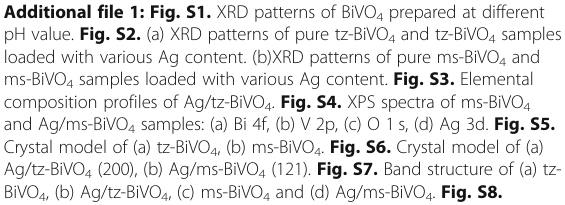
Additional file 1: Fig. S1. XRD patterns of BiVO 4 prepared at different pH value. Fig. S2. (a) XRD patterns of pure tz-BiVO 4 and tz-BiVO 4 samples loaded with various Ag content. (b)XRD patterns of pure ms-BiVO 4 and